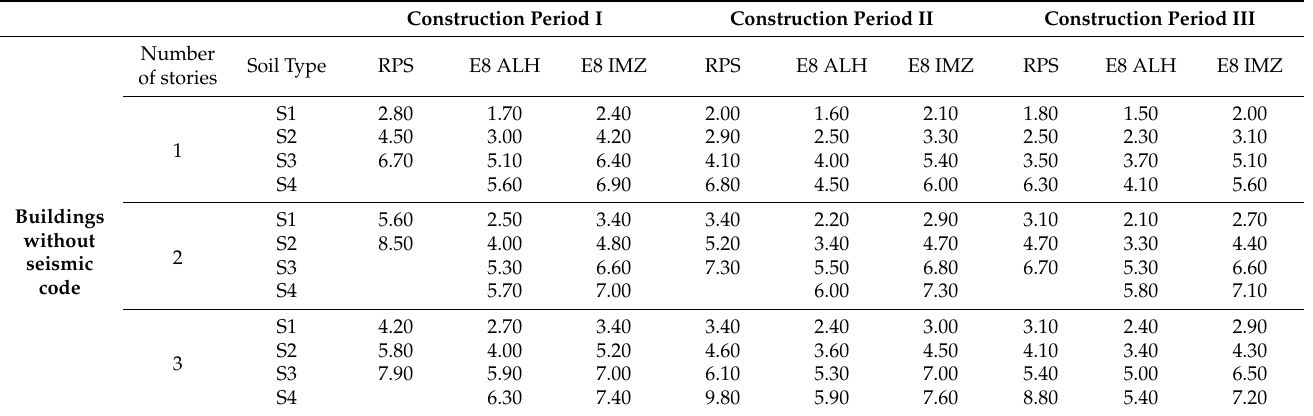
Table A4. Spectral displacement (cm) of the performance points for the RC building models according to both probabilistic scenarios (RPS2000 and Eurocode